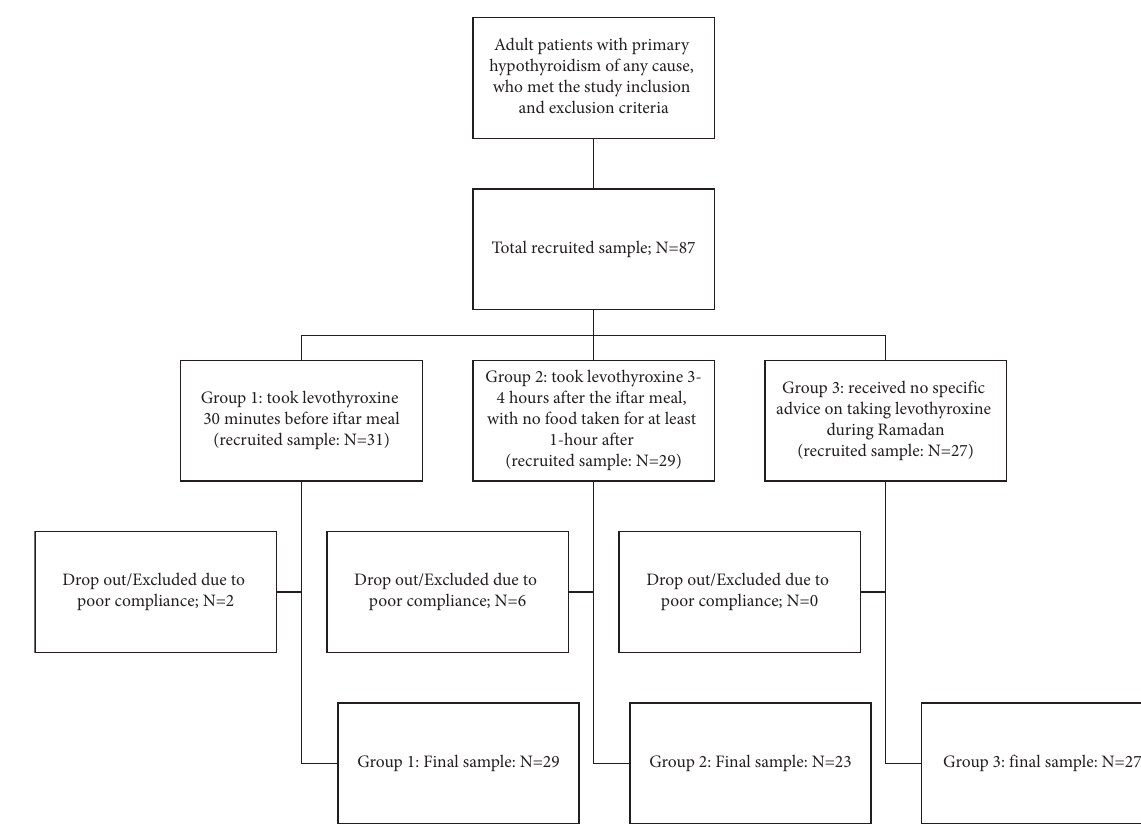
Figure 1: Participants fow